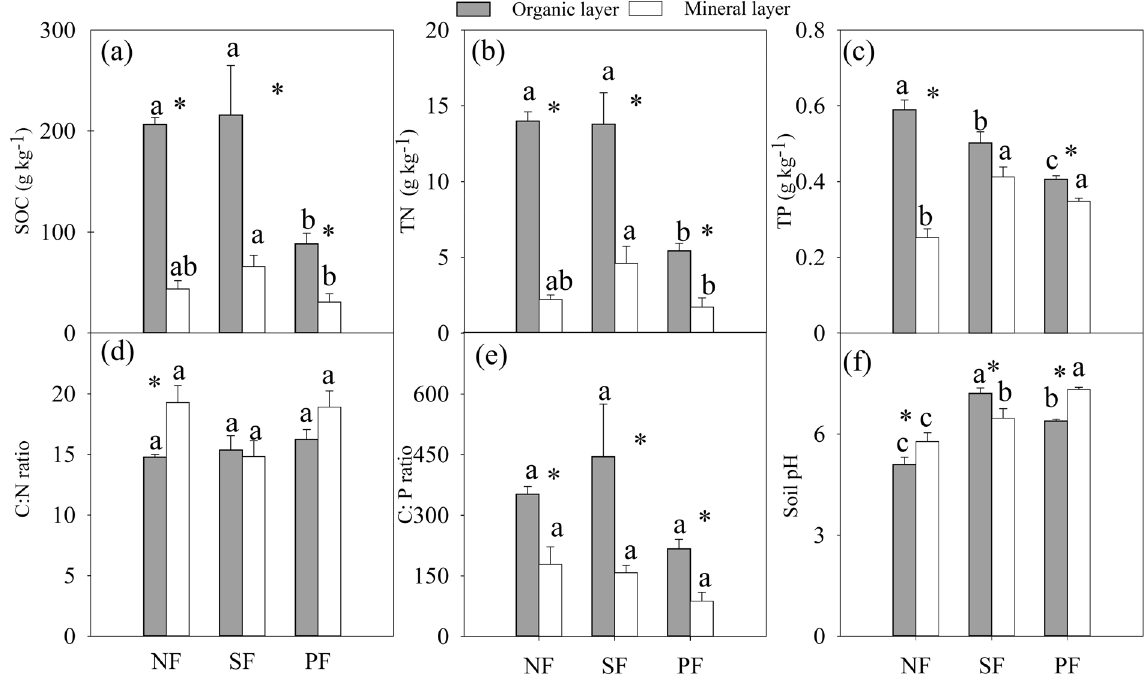
Figure 1. Effects of forest type conversion and soil layer on soil properties. Values indicate means ± SE, n = 4. Different letters within the same soil layer denote significant differences among forest types by one-way ANOVA. Asterisk indicates significant differences between the two soil layers by student t -test. NF: natural forest, SF: secondary forest and PF: spruce